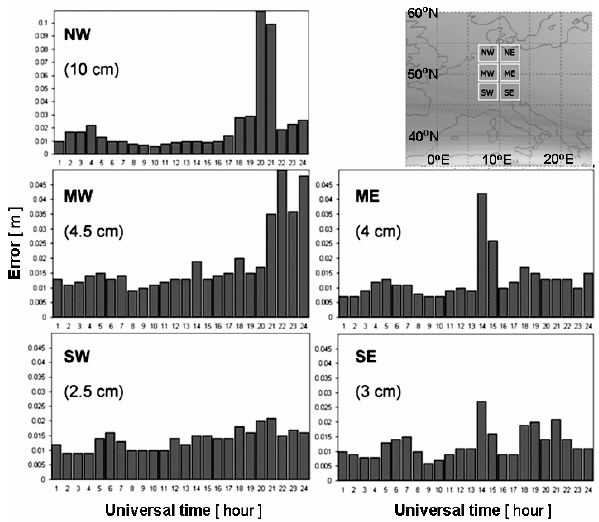
Fig. 4. Adverse space weather effects on the operational quality of reference networks. The network model integrity on 25 July 2004 for the NW, MW, SW, ME, SE areas of Germany (cf. the TEC map in the upper right